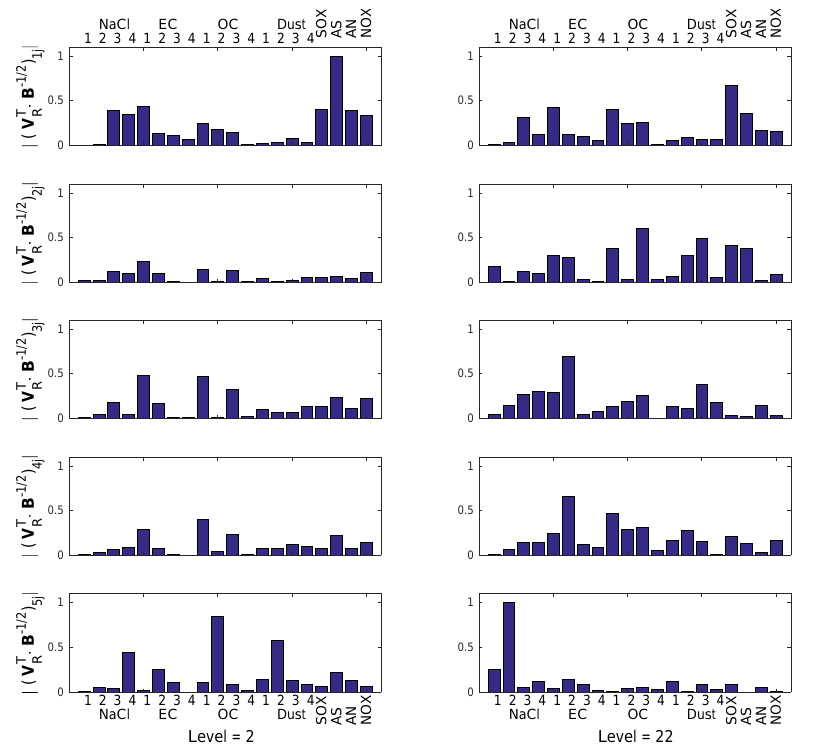
· B − 1 / 2 at the observation site, and for model layers 2 (left) and 22 Figure 5. The first five rows (from top to bottom) of the matrix V T R (right). The y values are normalized by dividing them by the maximum element. The x axis indicates the aerosol components in model space to which the elements of the row vectors correspond, namely, sea salt (NaCl), EC, OC, and dust, each in four size bins, as well as the four SIA components: sulfates (SO x ) other than (NH 4 ) 2 SO 4 , ammonium sulfate (AS), ammonium nitrate (AN), and nitrates (NO x ) other than NH 4 NO 3